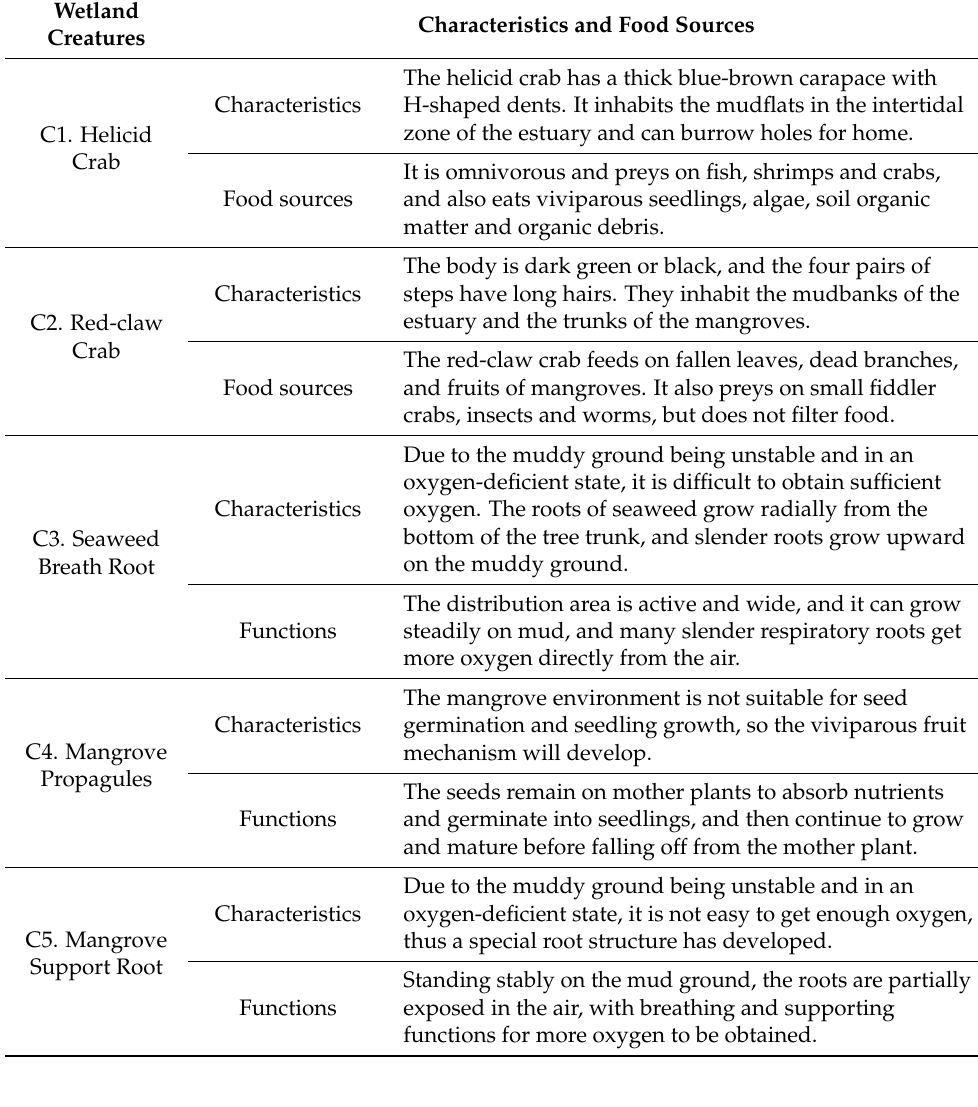
Table 4. Shin Feng mangrove forest and its creatures’ characteristics, food sources and functions.